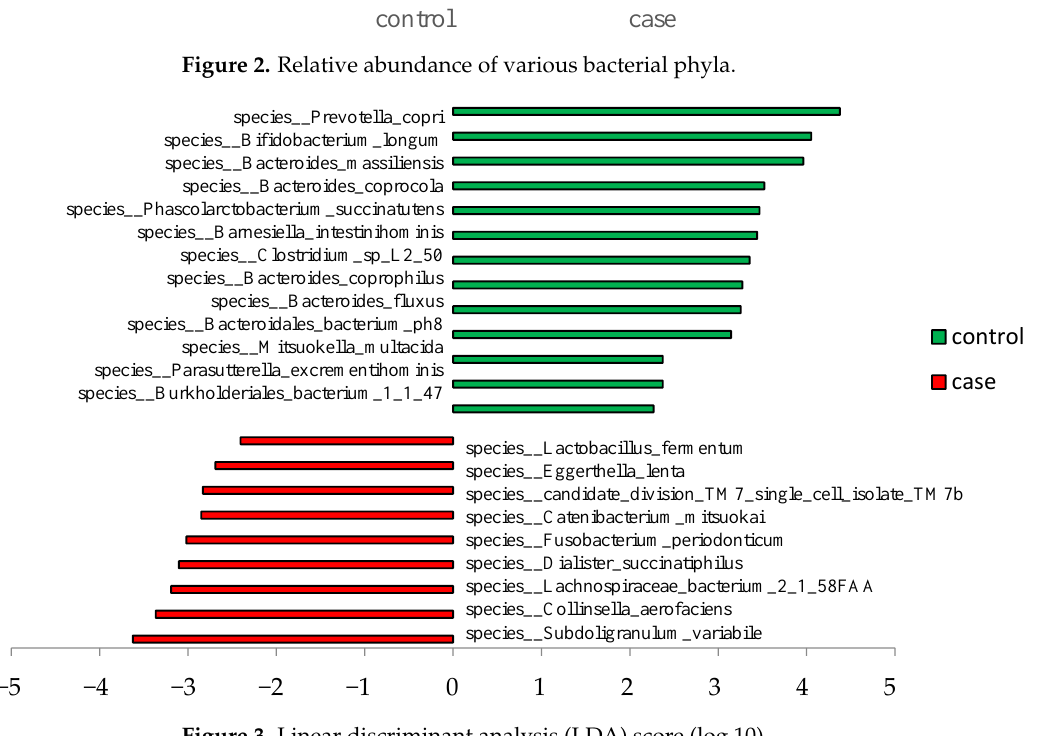
Figure 3. Linear discriminant analysis (LDA) score (log 10).